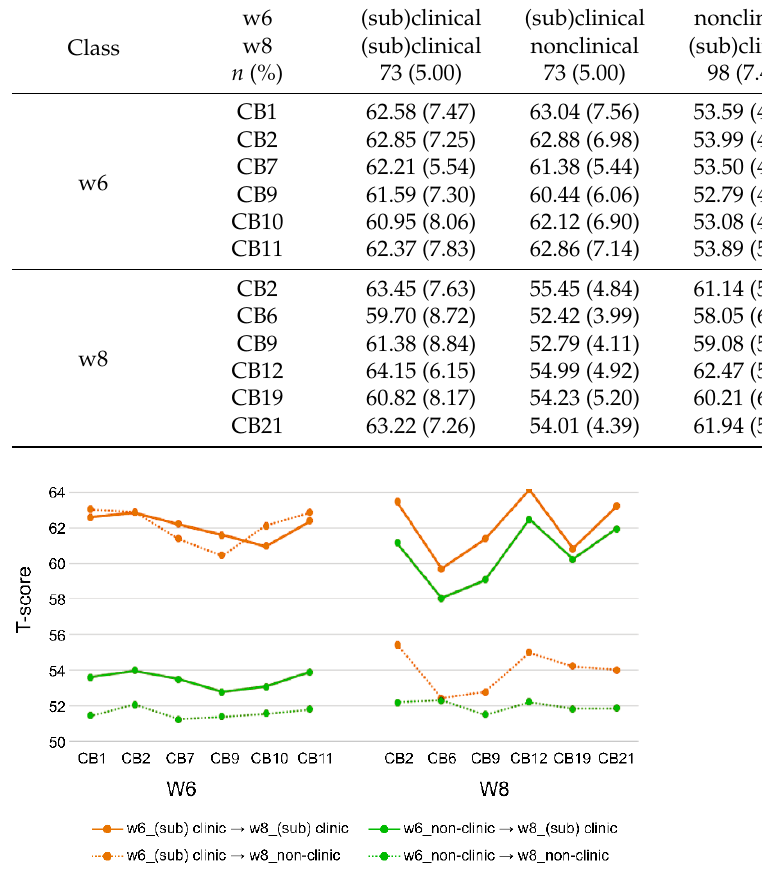
Figure 7. Approximately 50% of the (sub)clinical group at w6 was maintained as the (sub)clinical group at w8 (T-score ≥ 60). CB1 = emotionally reactive; CB2 = anxious/depressed; CB6 = attention problems; CB7 = aggressive behaviors; CB9 = DSM affective problems; CB10 = DSM anxiety problems; CB11 = DSM pervasive developmental problems; CB12 = DSM attention-deficit/hyper-activity problems; CB19 = DSM conduct problems; CB21 = posttraumatic stress problems.